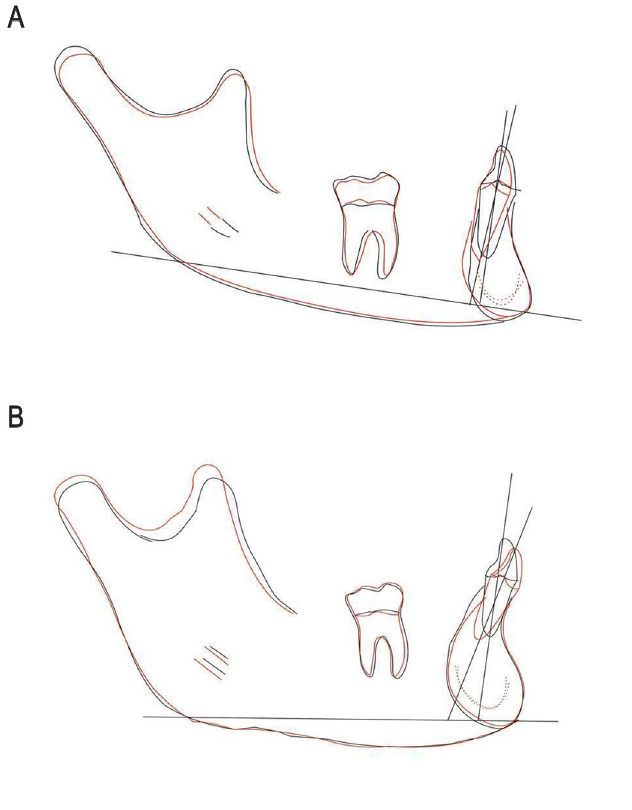
A Fig.1. A- Group 1(IMPA T 1 -T 0 ≤ 5˚). B- Group 2 (IMPA T 1 -T 0 > 5˚).